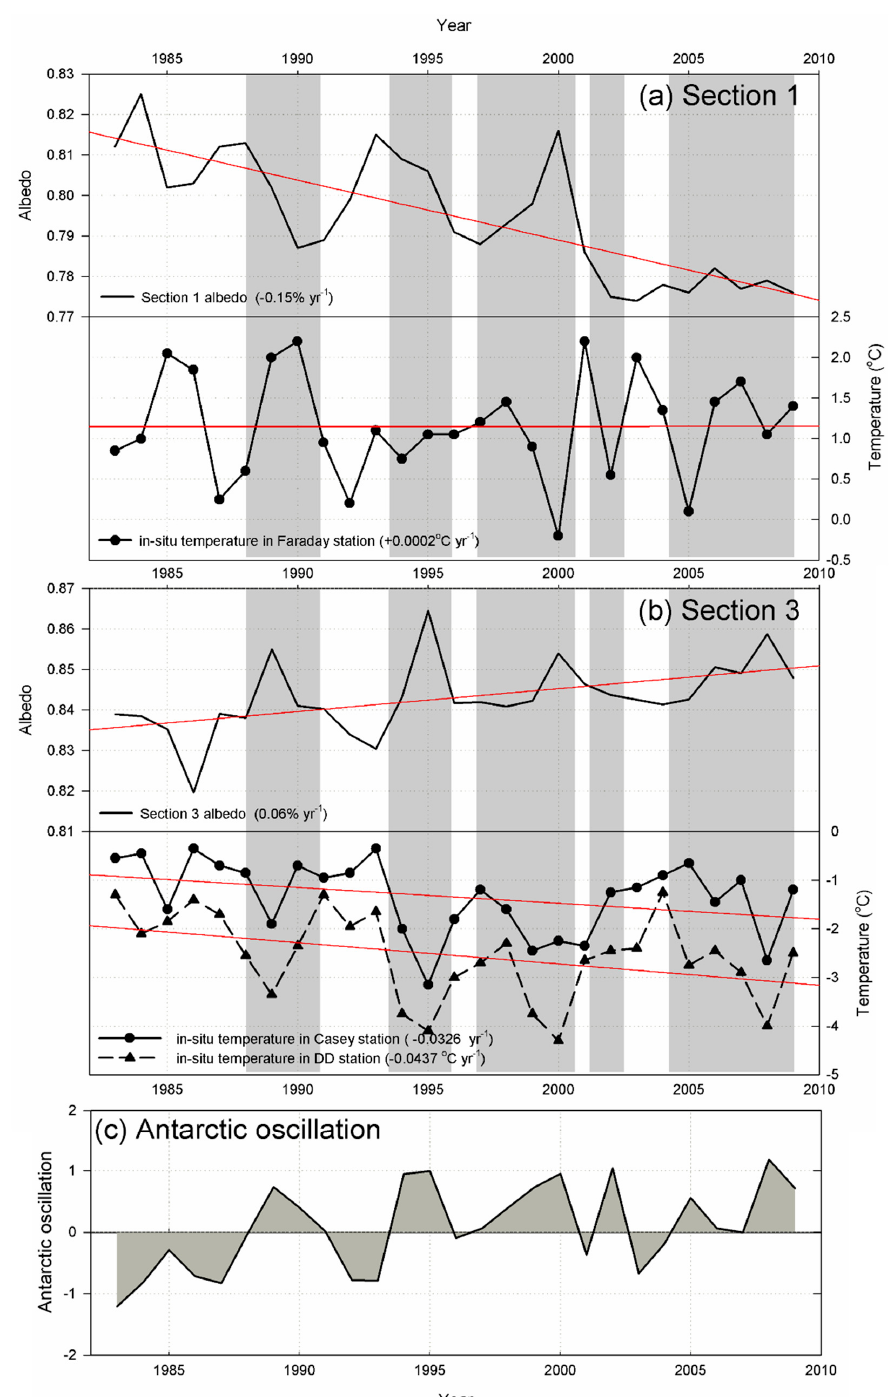
Figure 4. Time series of albedo and climatic variables (temperature and Antarctic oscillation) comparing the same period in Sections 1 and 3. Black line is time series and red line is trend of each variable (from the top: albedo, in situ temperature). ( a ) Section 1 (from the top: albedo and Faraday/Vernadsky station); ( b ) Section 3 (from the top: albedo, Casey station shown by dotted line, Dumont d’Urville shown by a triangle line); and ( c ) Antarctic oscillation.